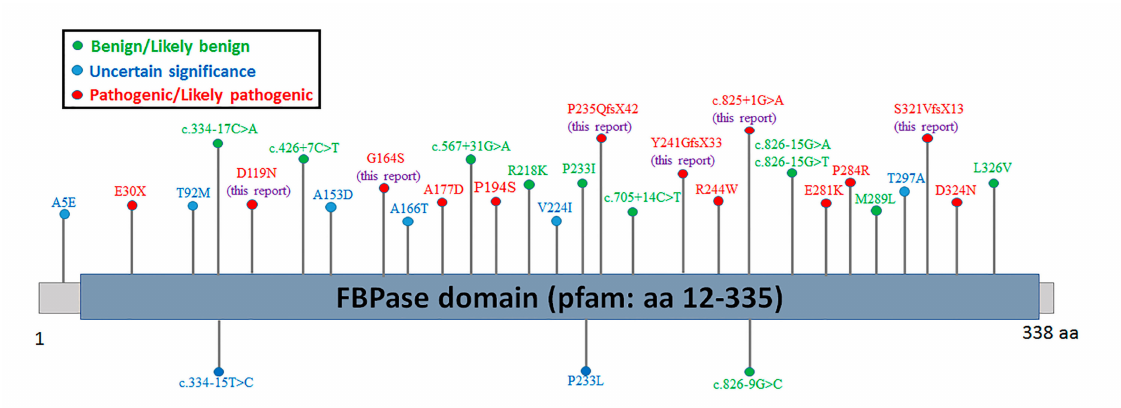
Figure 5. Distribution schematic of the variants of FBP1 gene in the ClinVar database. aa: amino